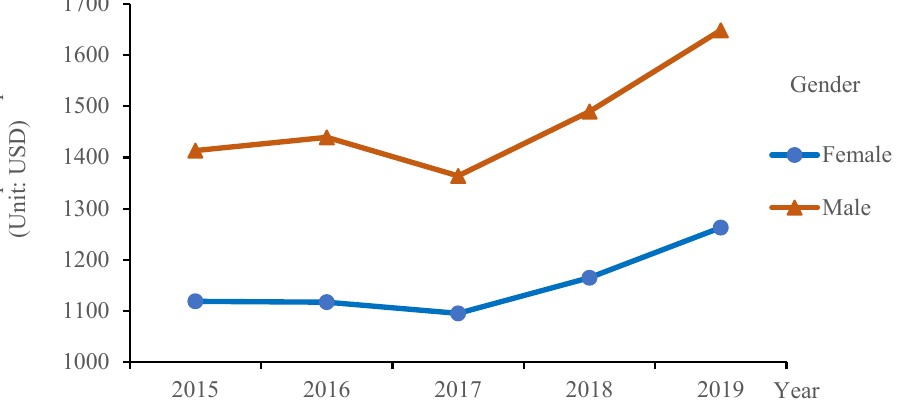
Figure 2. Trends in inpatient expenditure for different genders for respiratory diseases for 2015–2019.